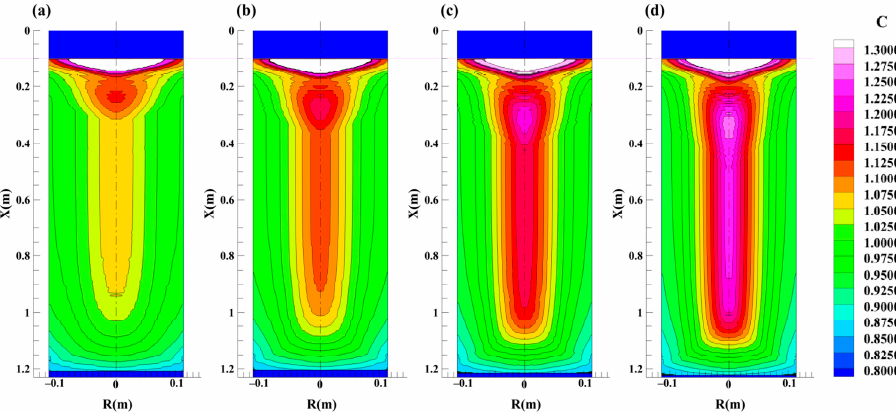
Figure 17. Distribution of C concentration at varying melting rate: ( a ) 90 kg/h, ( b ) 120 kg/h, ( c ) 150 kg/h and ( d ) 180 kg/h.